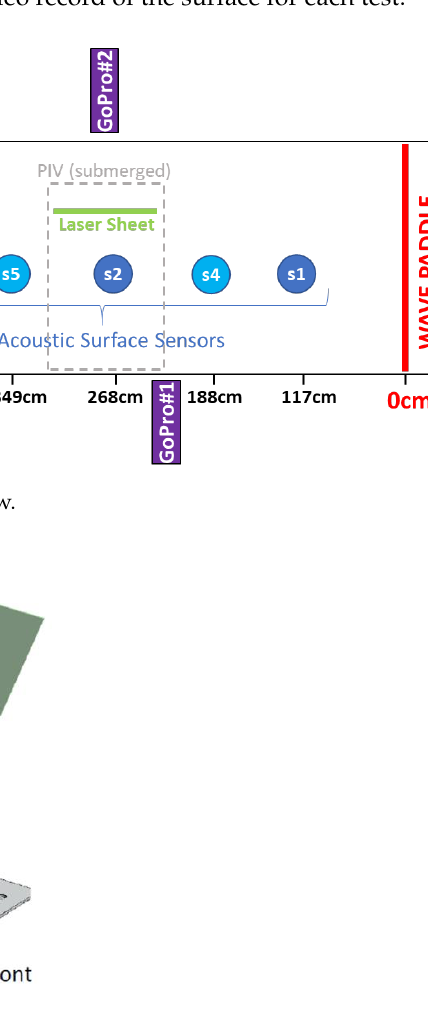
Figure 1. Experimental layout, plan view.